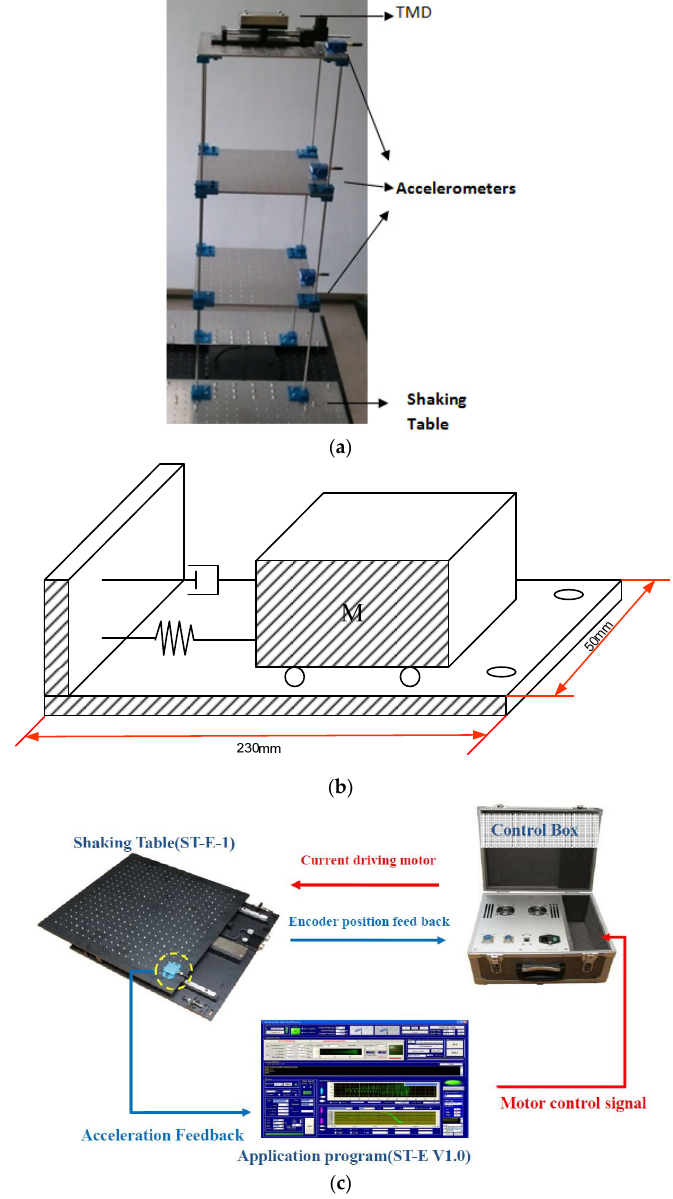
Figure 4. Tuned mass damper (TMD) passive vibration controller installed on scaled test model: ( a ) scaled frame building, attached with controllers and monitoring systems; ( b ) TMD; ( c ) process of seismic excitation applied to structure through shaking table.